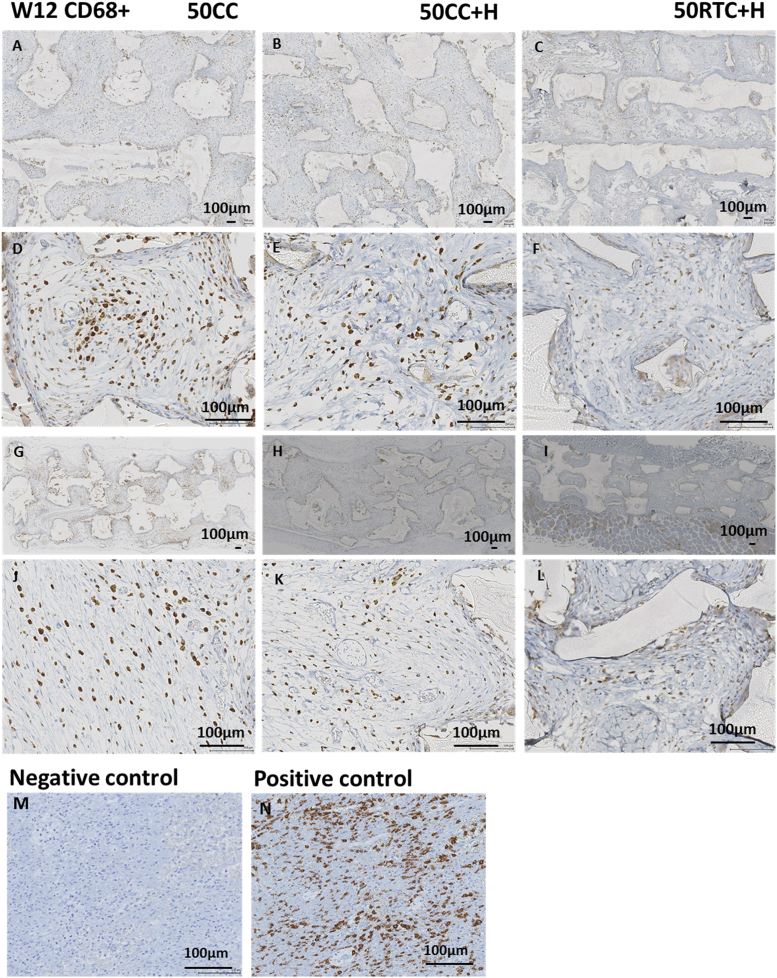
Immunohistochemistry of the host macrophage response towards scaffolds in vivo at week 12. Tissue integration of middle-in-plane (A-F) and cross-sectional view (G-L) of the scaffolds by CD68 (pan-macrophage/monocyte marker) staining at (A-C, G-I) ×4 and (D-F, J-I) ×20 magnifications. (M) Negative control (rat appendix); (N) positive control (rat liver). Scale bar: 100 μm.